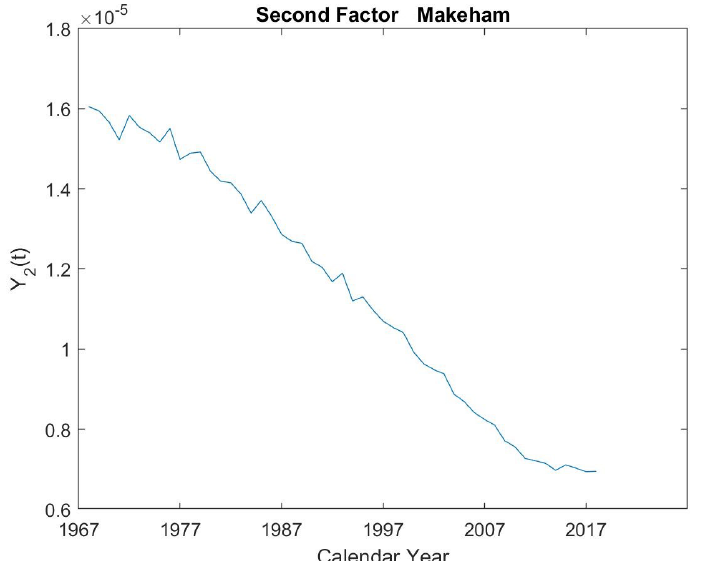
Figure 1. The figure plots the values of the two factors, Y 1 , Y 2 .